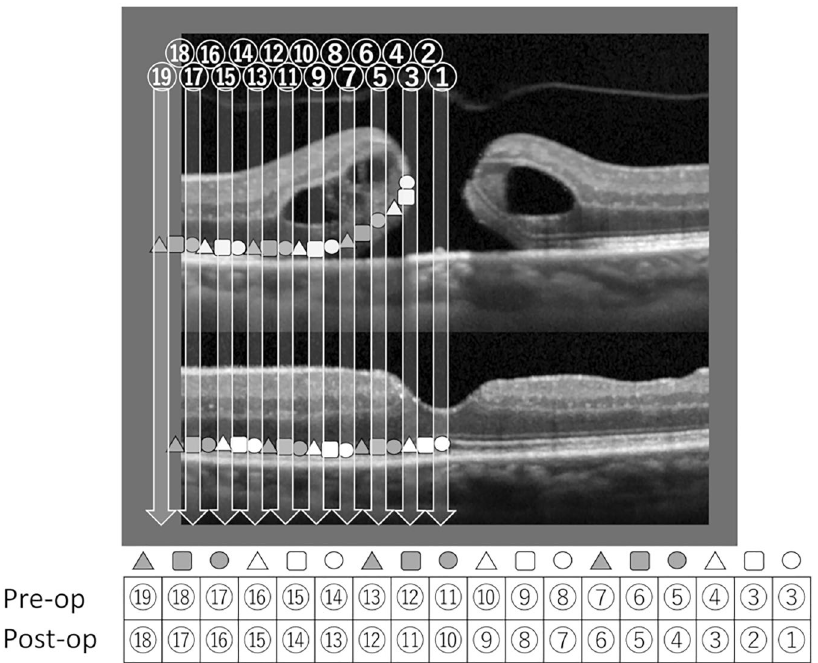
Figure 3. Schematic diagram and optical coherence tomography image showing the mechanism of metamorphopsia before and after macular hole surgery. The photoreceptor cells near the center of the macula are detached from retinal pigment epithelium and efferently displaced. There are no photoreceptor cells that receive light from light sources ① and ② in the macular hole (MH) and there are two photoreceptor cells that receive light from light source ③ . After the closure of the MH, the photoreceptor cells are slightly displaced from their original position, which generates metamorphopsia postoperatively. Dislocated Müller cells may also contribute to generate metamorphopsia, working as optic guide to transfer photons to dislocated